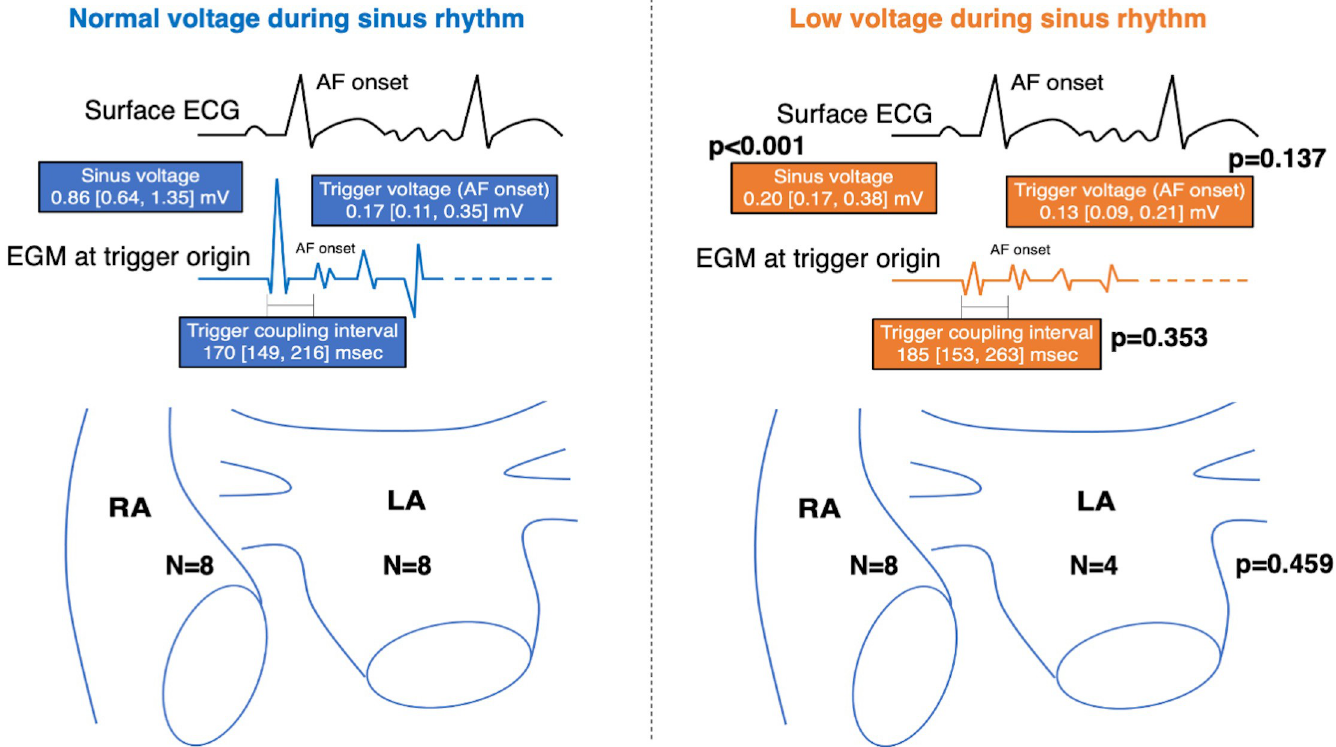
Fig 5. Difference in the electrophysiological characteristics between the normal sinus voltage and low sinus voltage groups.